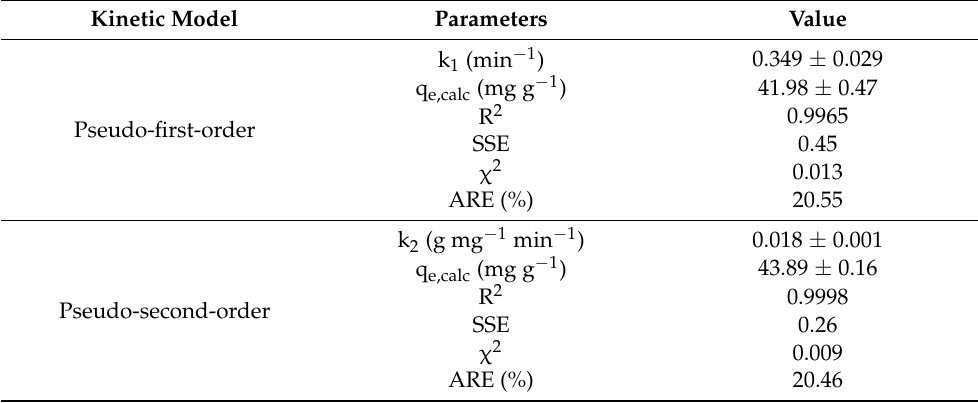
Table 6. Tested kinetic model parameters.